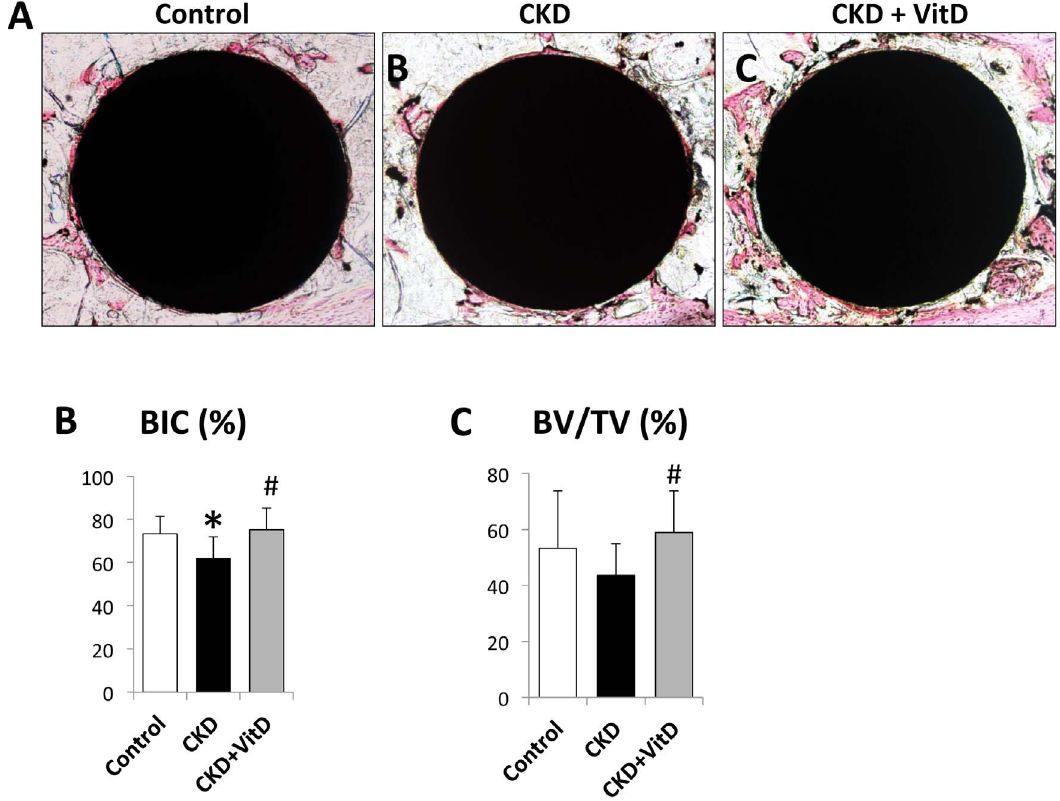
Figure 4. Histological and histomorphometrical analysis of the implants after 2-week healing. (A) Representative images of undecalified sections from all three groups; VitD injection significantly increased (B) Bone-implant contact ratio (BIC, %), and (C) bone volume (BV/TV) in the circumferential zone within 100 m m of the implant surface. *: p , 0.05 vs Control; # : p , 0.05 vs CKD.